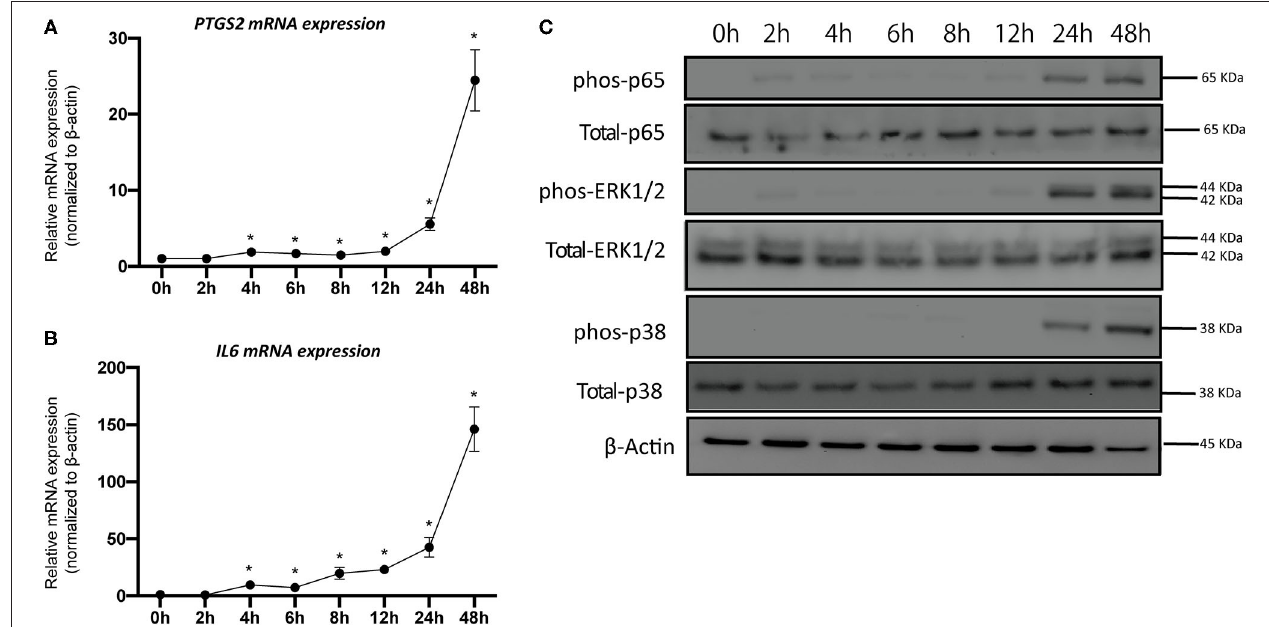
FIGURE 3 | Combined IL-1 β and IL-17 activate the immune phenotype of pPDLSCs. A time-course experiment was conducted to investigate the response of pPDLSCs to the combined cytokine treatment over 48h. Both PTGS2 and IL-6 mRNA expression levels were significantly elevated after 4h, but highly upregulated by 24h and 48h (A,B) . Western blotting showed that both nuclear factor-kappa B (NF- κ B) and mitogen-activated protein kinase (MAPK) pathways were activated by the combined cytokine treatment (C) . * p < 0.05 as compared to 0h control.